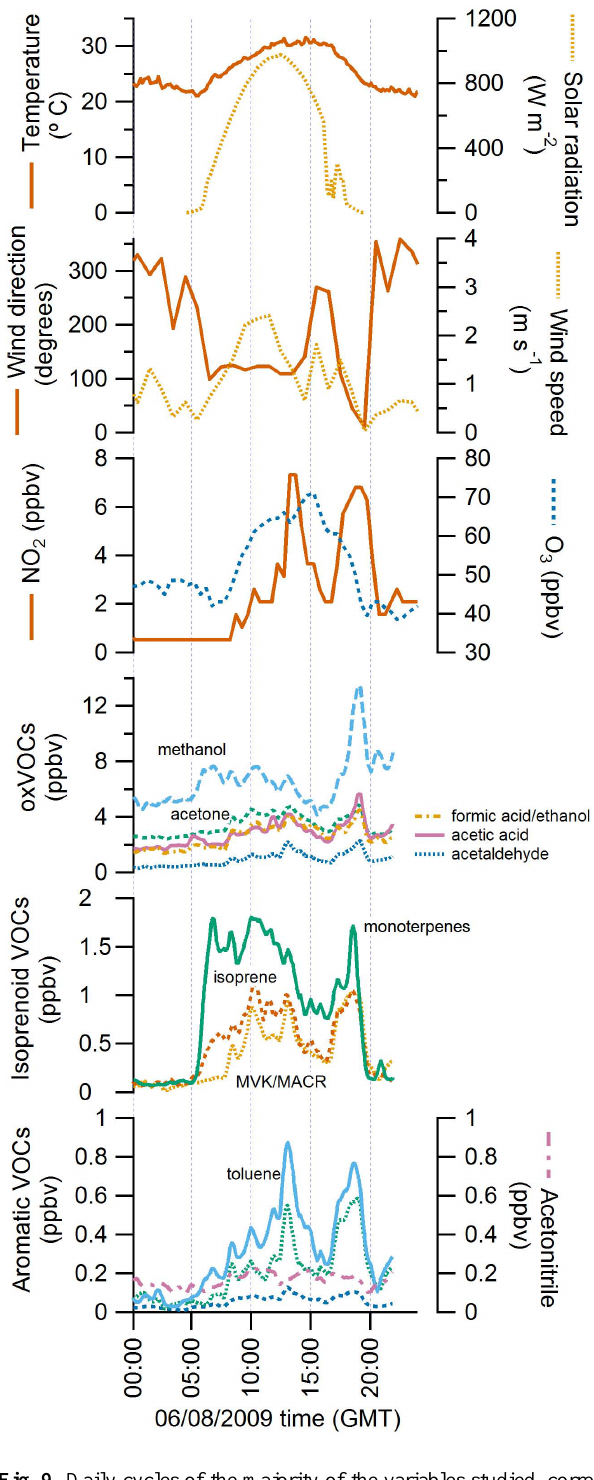
Fig. 9. Daily cycles of the majority of the variables studied, corre- sponding to the 6 August 2009. Panels and traces are the same as in Fig.